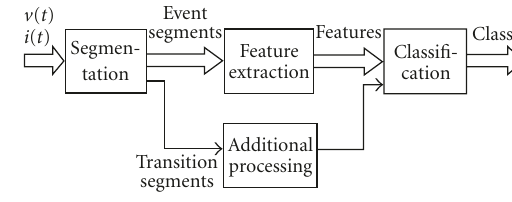
Figure 1: The processes of classification of power quality distur-